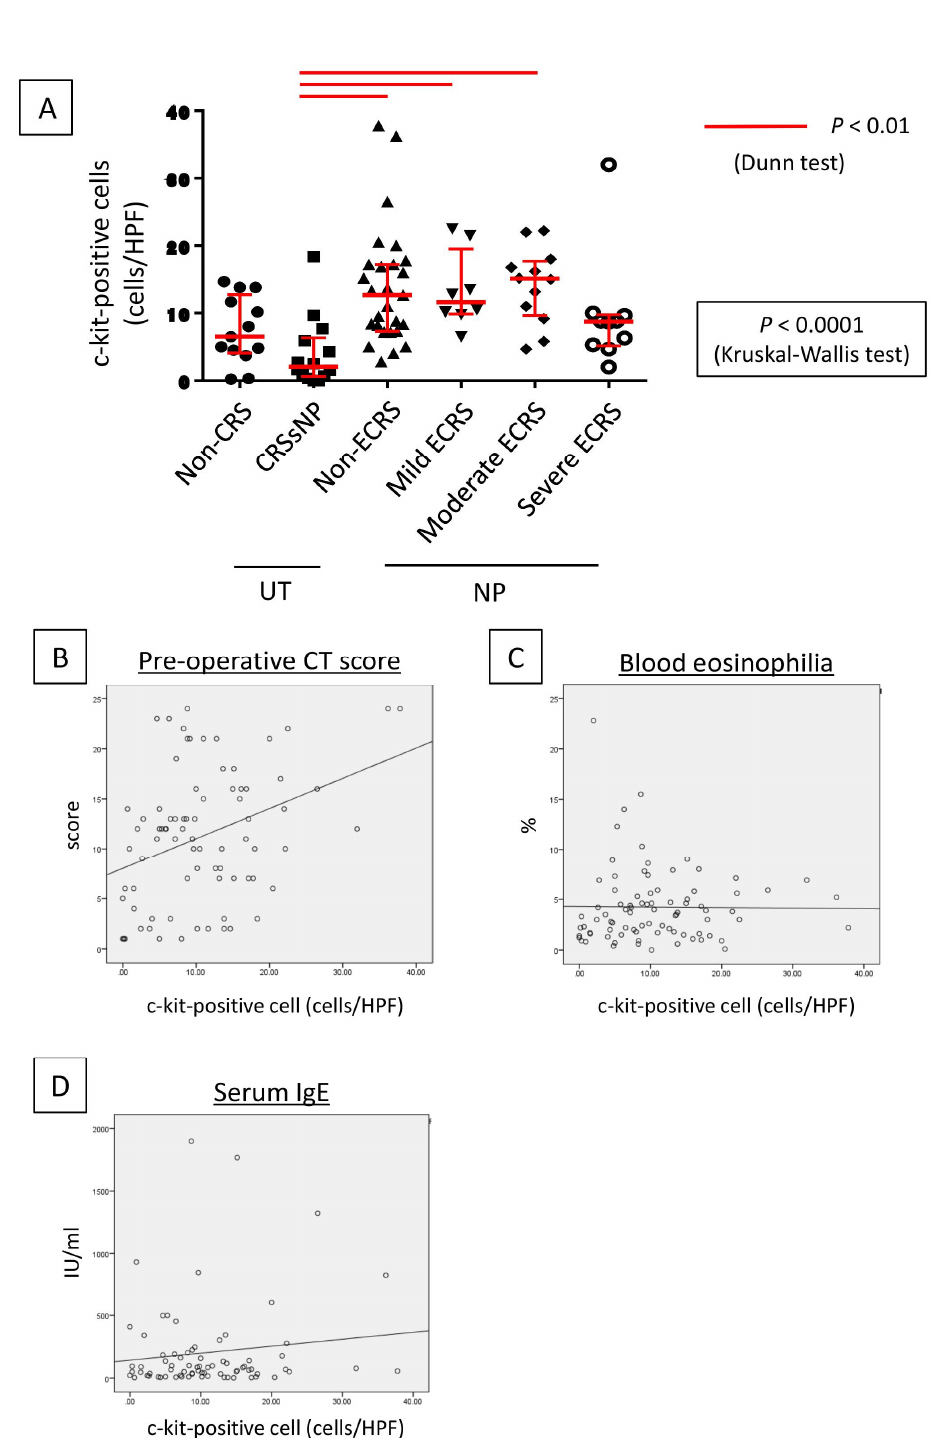
Figure 3. Lesion infiltration by c ‐ kit ‐ positive cells and the number of c ‐ kit ‐ positive cells. ( A ) Examination of the number of c ‐ kit positive cells in the hotspot of each case. The number of c ‐ kit ‐ positive cells increased in the nasal polyp groups ( p < 0.0001, Kruskal–Wallis test). Relationship between the number of c ‐ kit positive cells and the preoperative CT score ( B ), eosinophil ratio in peripheral blood ( C ), and total serum IgE level ( D ).